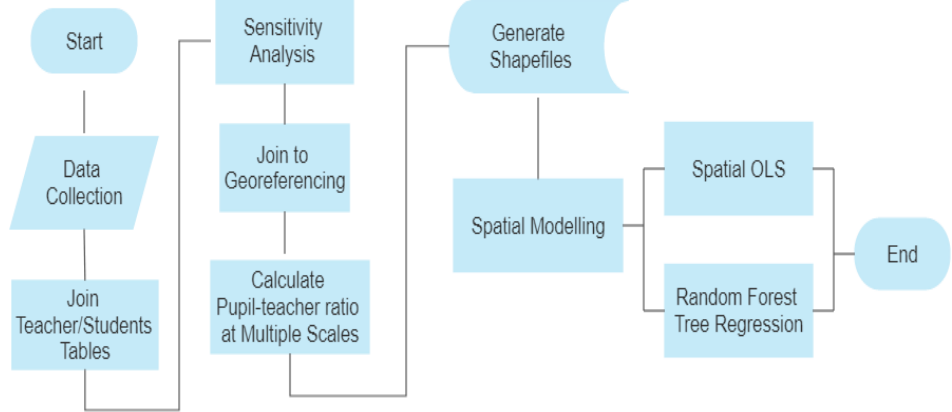
Figure 3. Chart showing the general flow of data and tools in the toolbox.